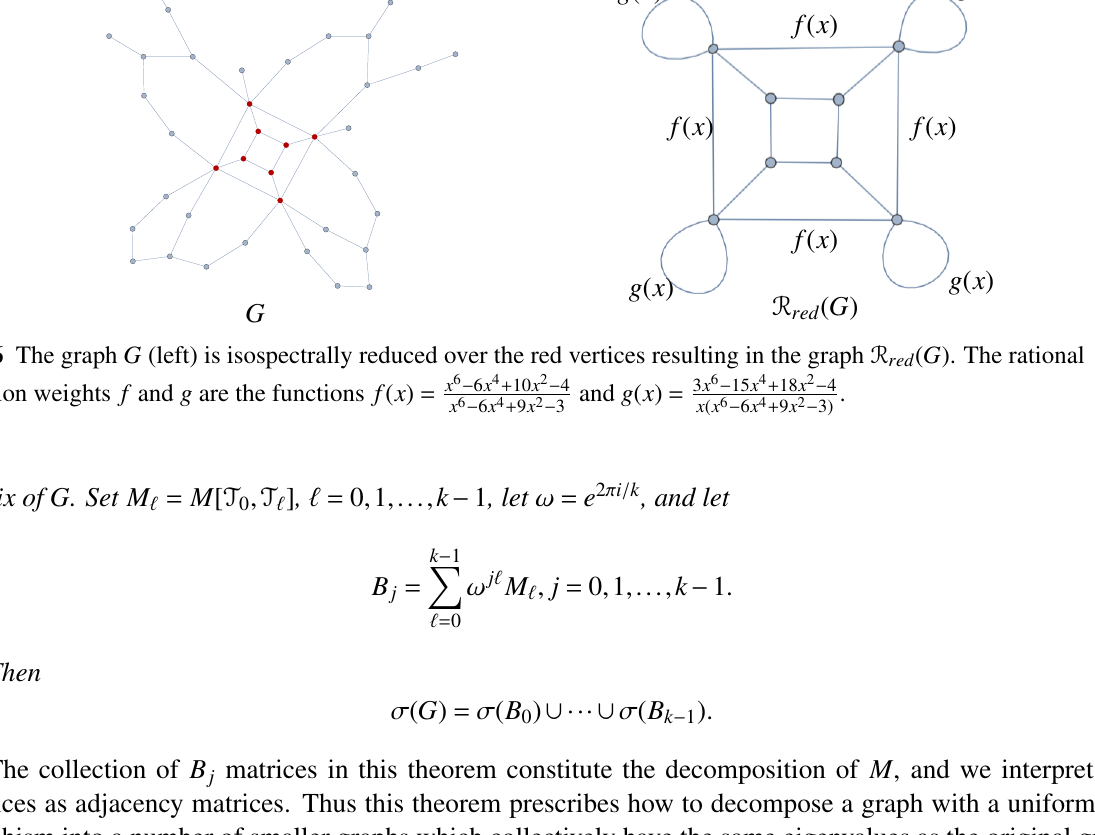
, T (cid:96) ] , (cid:96) = 0 , 1 ,..., k − 1 , let ω = e 2 π i / k , and 0